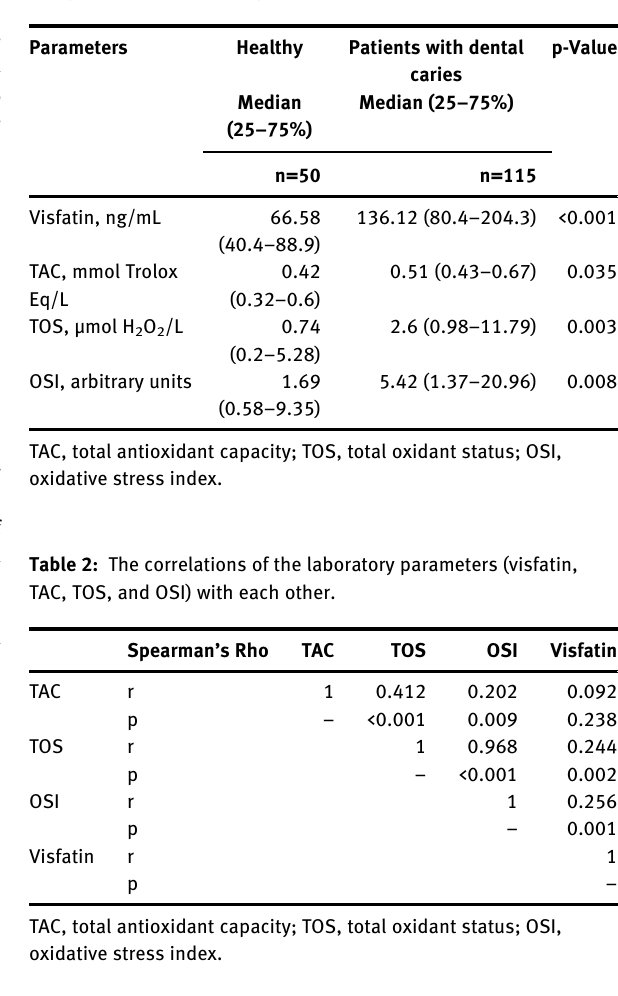
Table  : Comparison of laboratory parameters in caries active group and caries-free group.